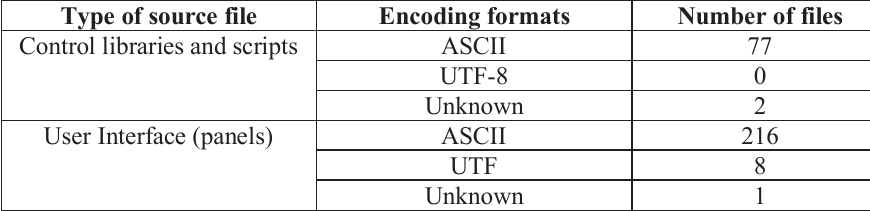
Table 1. Summary of files using different encoding